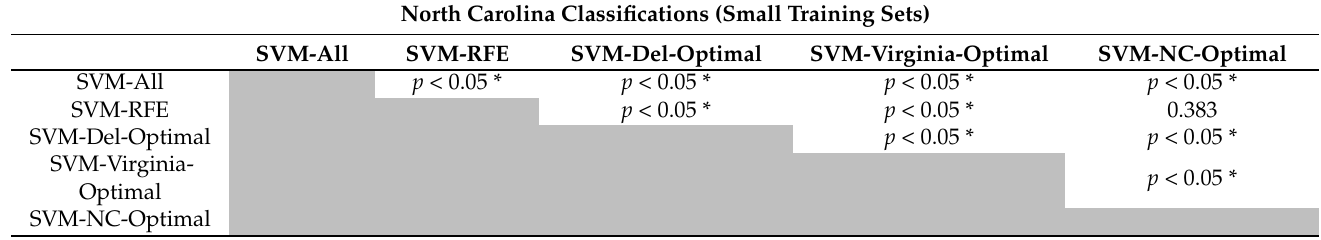
Table A6. Paired t -test p -values for North Carolina classifications trained from the large training sets. (* Indicates at a 95% confidence that the differences in mean classification accuracies between classification groups are statistically significant, p <